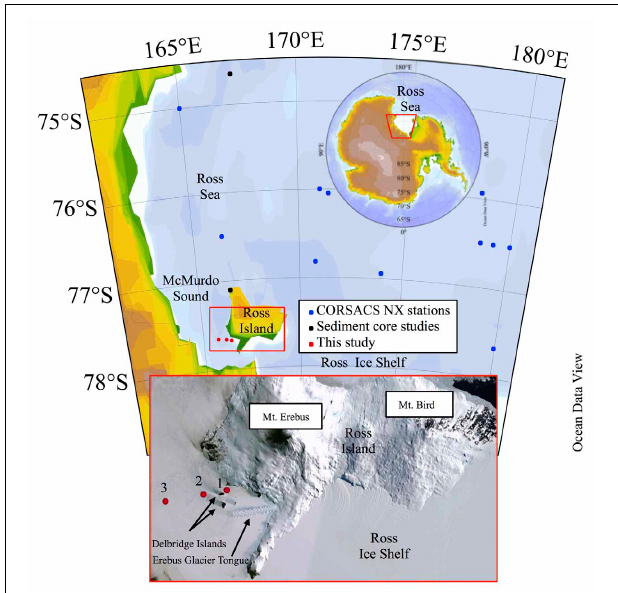
FIGURE 1 | Maps and satellite photo of the study area. The red boxes highlight the study area, zooming in from the continent (upper red trapezoid), to the Ross Sea (middle red box), to McMurdo Sound (bottom image) which shows the sampling sites in red circles relative to Ross Island and the Delbridge Islands. Maps were generated in Ocean Data View (Schlitzer,